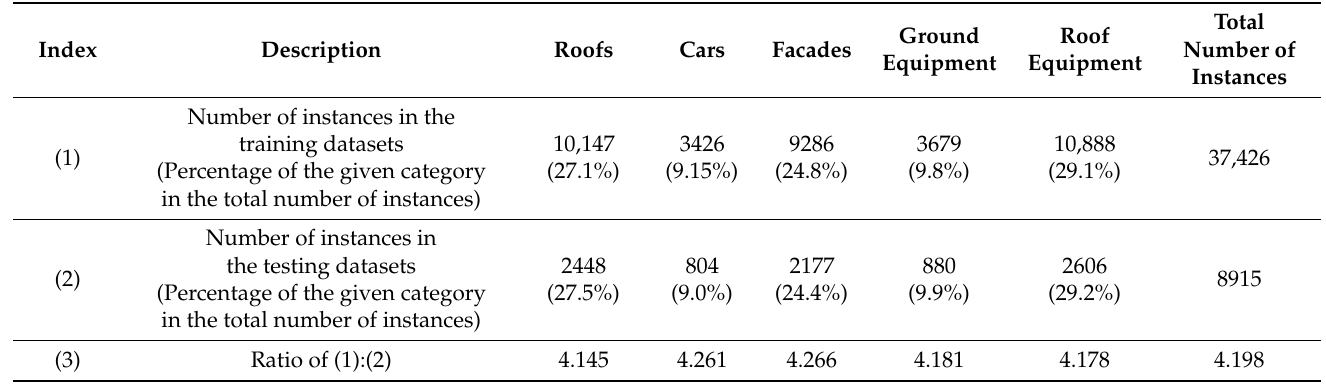
Table 2. Numbers of instances in the